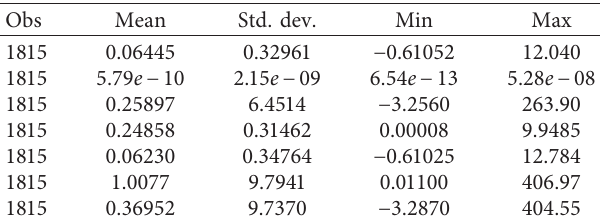
Table 2: Variable